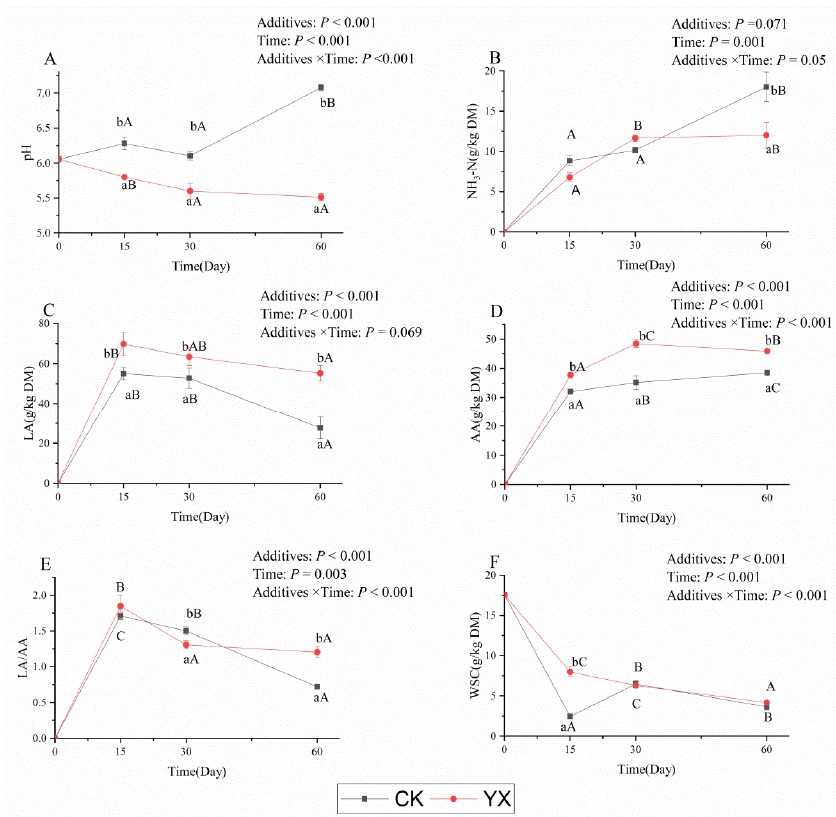
Figure 1. Changes in fermentation parameters (( A ): pH value; ( B ): NH 3 -N; ( C ): LA; ( D ): AA; ( E ): LA/AA; ( F ): WSC) in alfalfa silages during ensiling for 60 d. Values with different superscript lowercase letters show significant differences among treatments on the same ensiling day, values with different superscript capital letters show significant differences among ensiling days in the same treatment ( p < 0.05). CK, control; YX, inoculated with commercial LAB YX; NH 3 -N, ammoniacal nitrogen; LA, lactic acid; AA, acetic acid; LA/AA, the ratio of lactic acid to acetic acid; WSC, water-soluble carbohydrate.